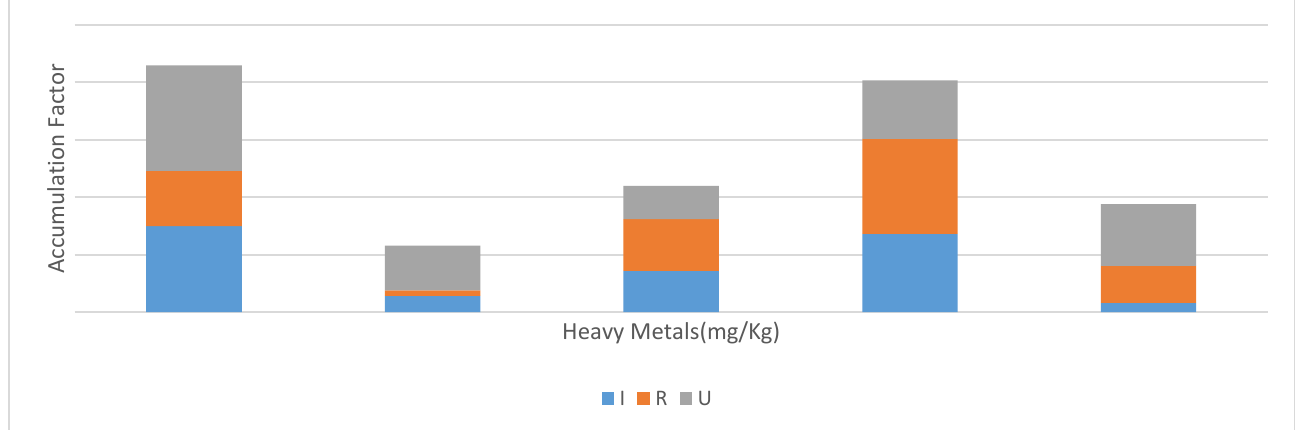
Figure 4. Transfer Factor ( TF ) for the study metals.